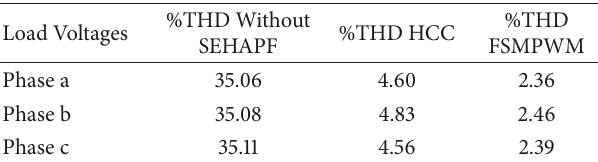
Table 2: Comparison of THD % analysis of load voltages between FSMPWM and HCC used in SEHAPF.